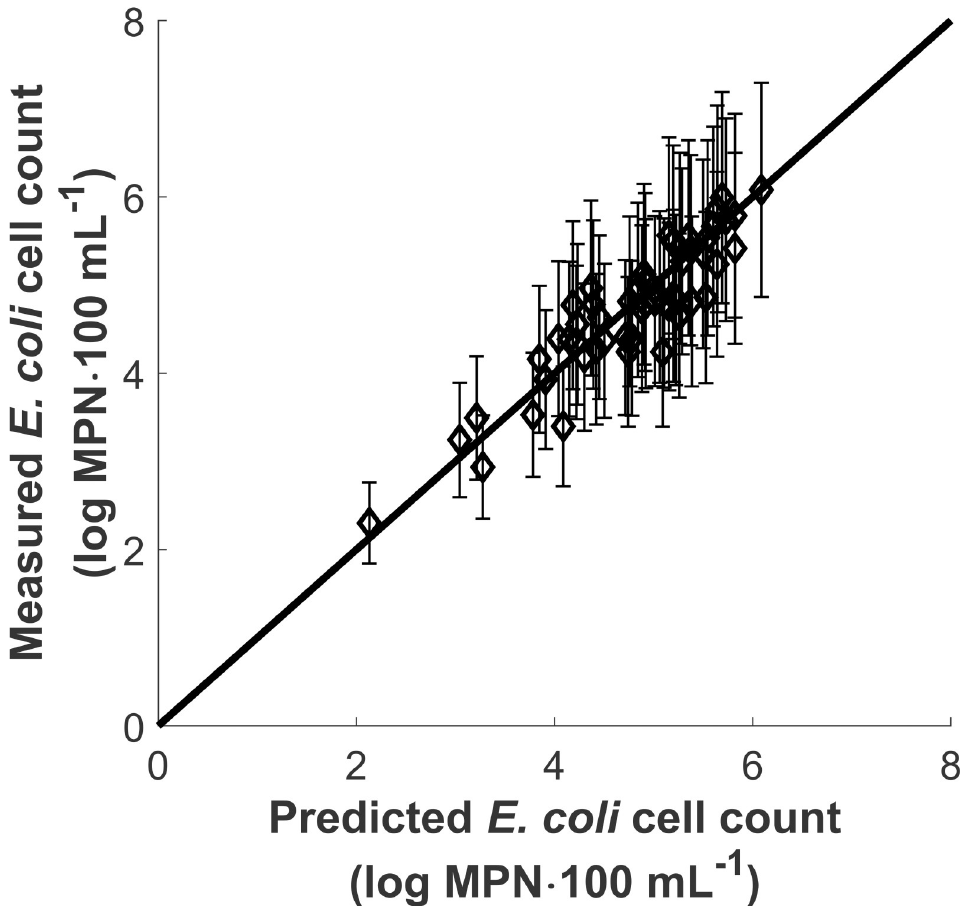
Fig 3. Measured vs. computed E . coli cell counts during bench assays using ‘best-fit’ model parameters (R 2 = 0.812, N = 54). Error bars show 20% uncertainty on measured E . coli cell counts.